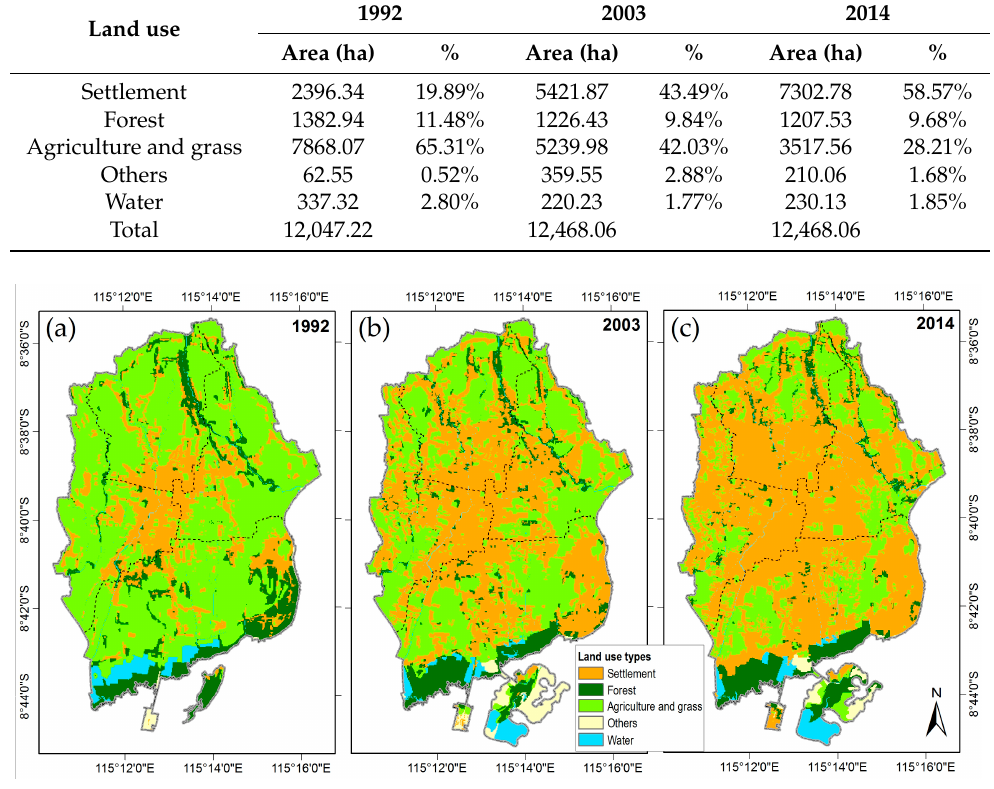
Figure 3. Distribution of land use types in Denpasar, Indonesia from topographic maps. ( a ) 1992; ( b ) 2003; and ( c ) 2014. Table 2. Area of each type of land use in Denpasar from 1992 to 2014 and their proportion of total area.